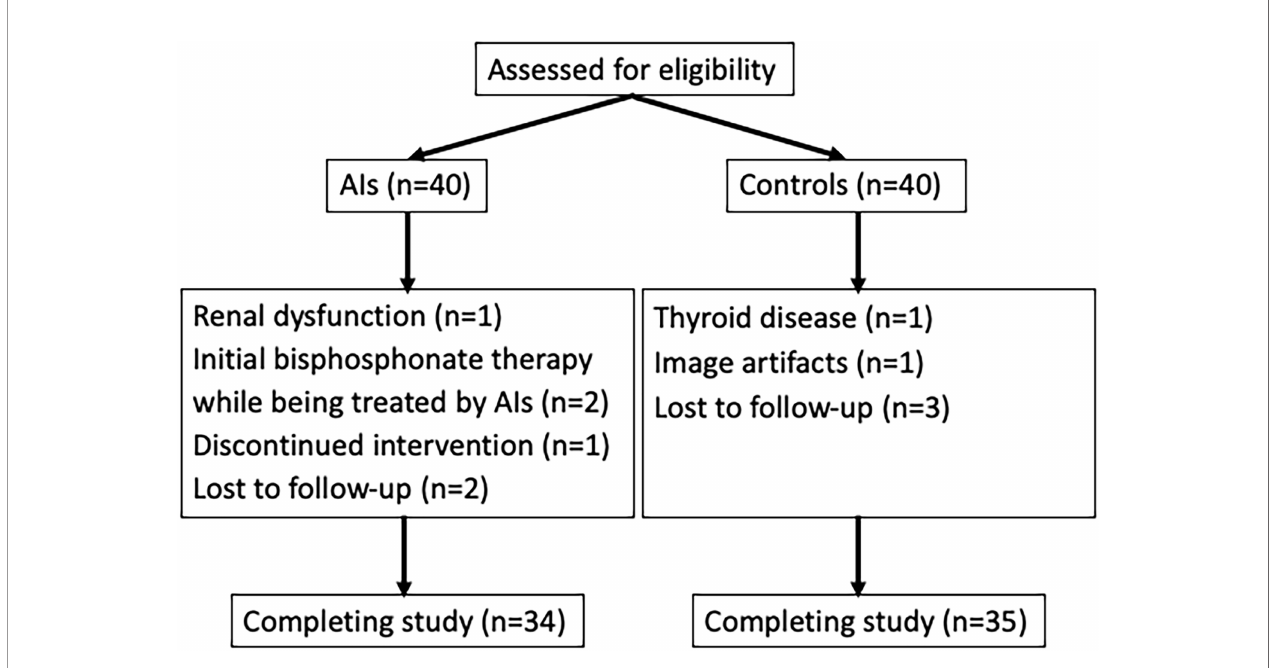
FIGURE 1 | Flow diagram of study subjects. AIs, aromatase